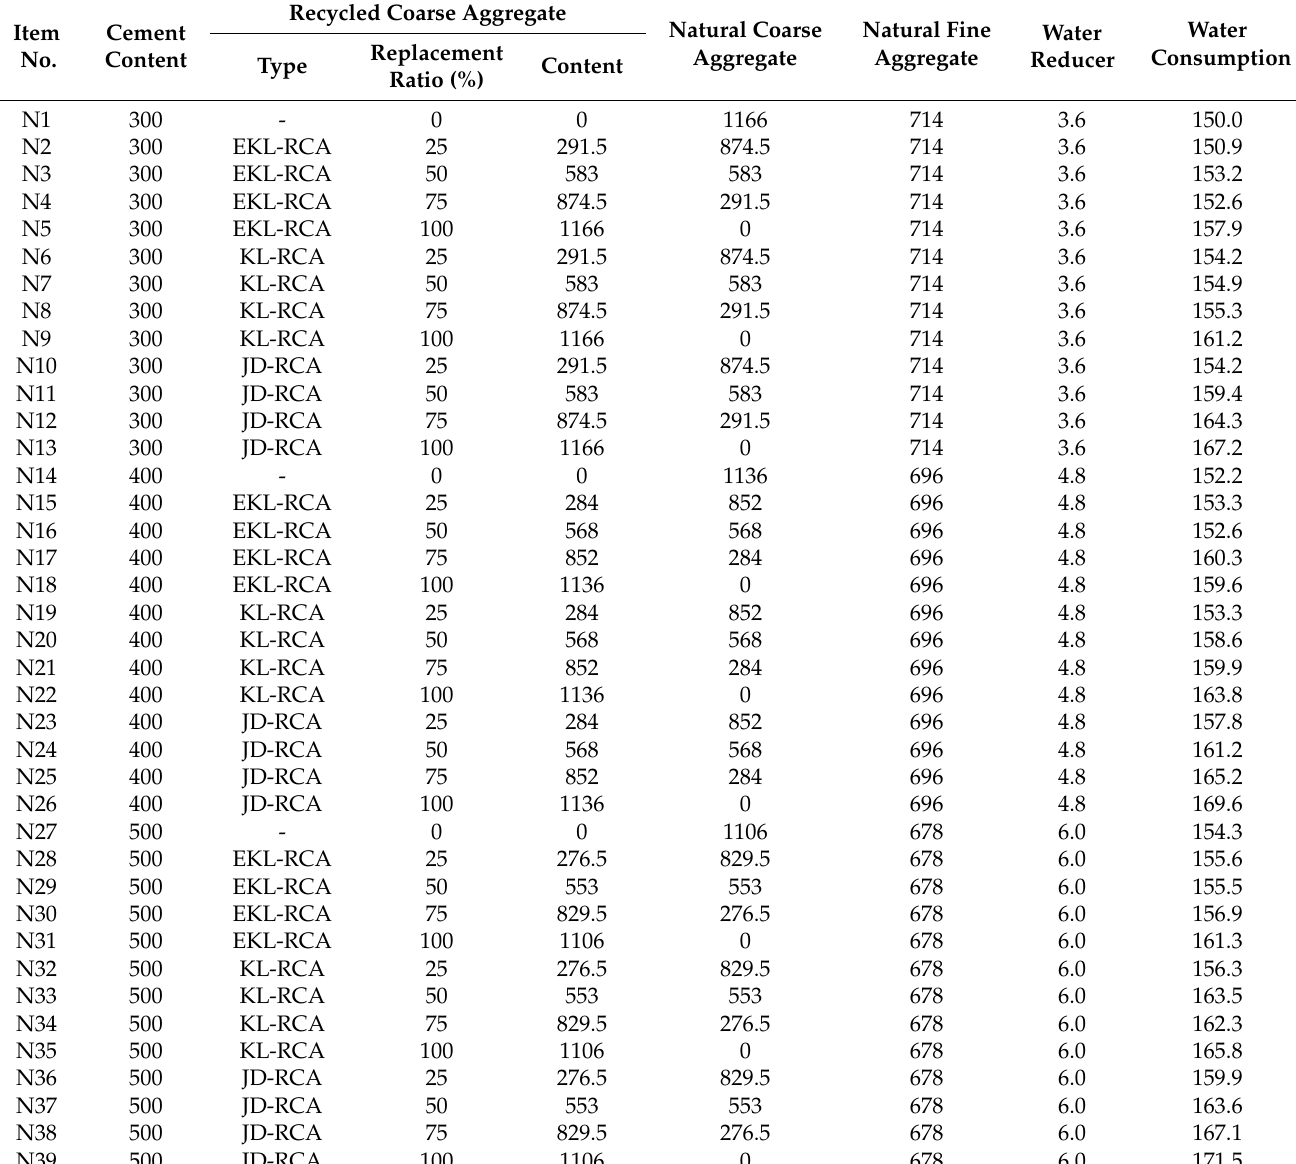
Table 7. Mixing proportions of concrete (kg/m 3